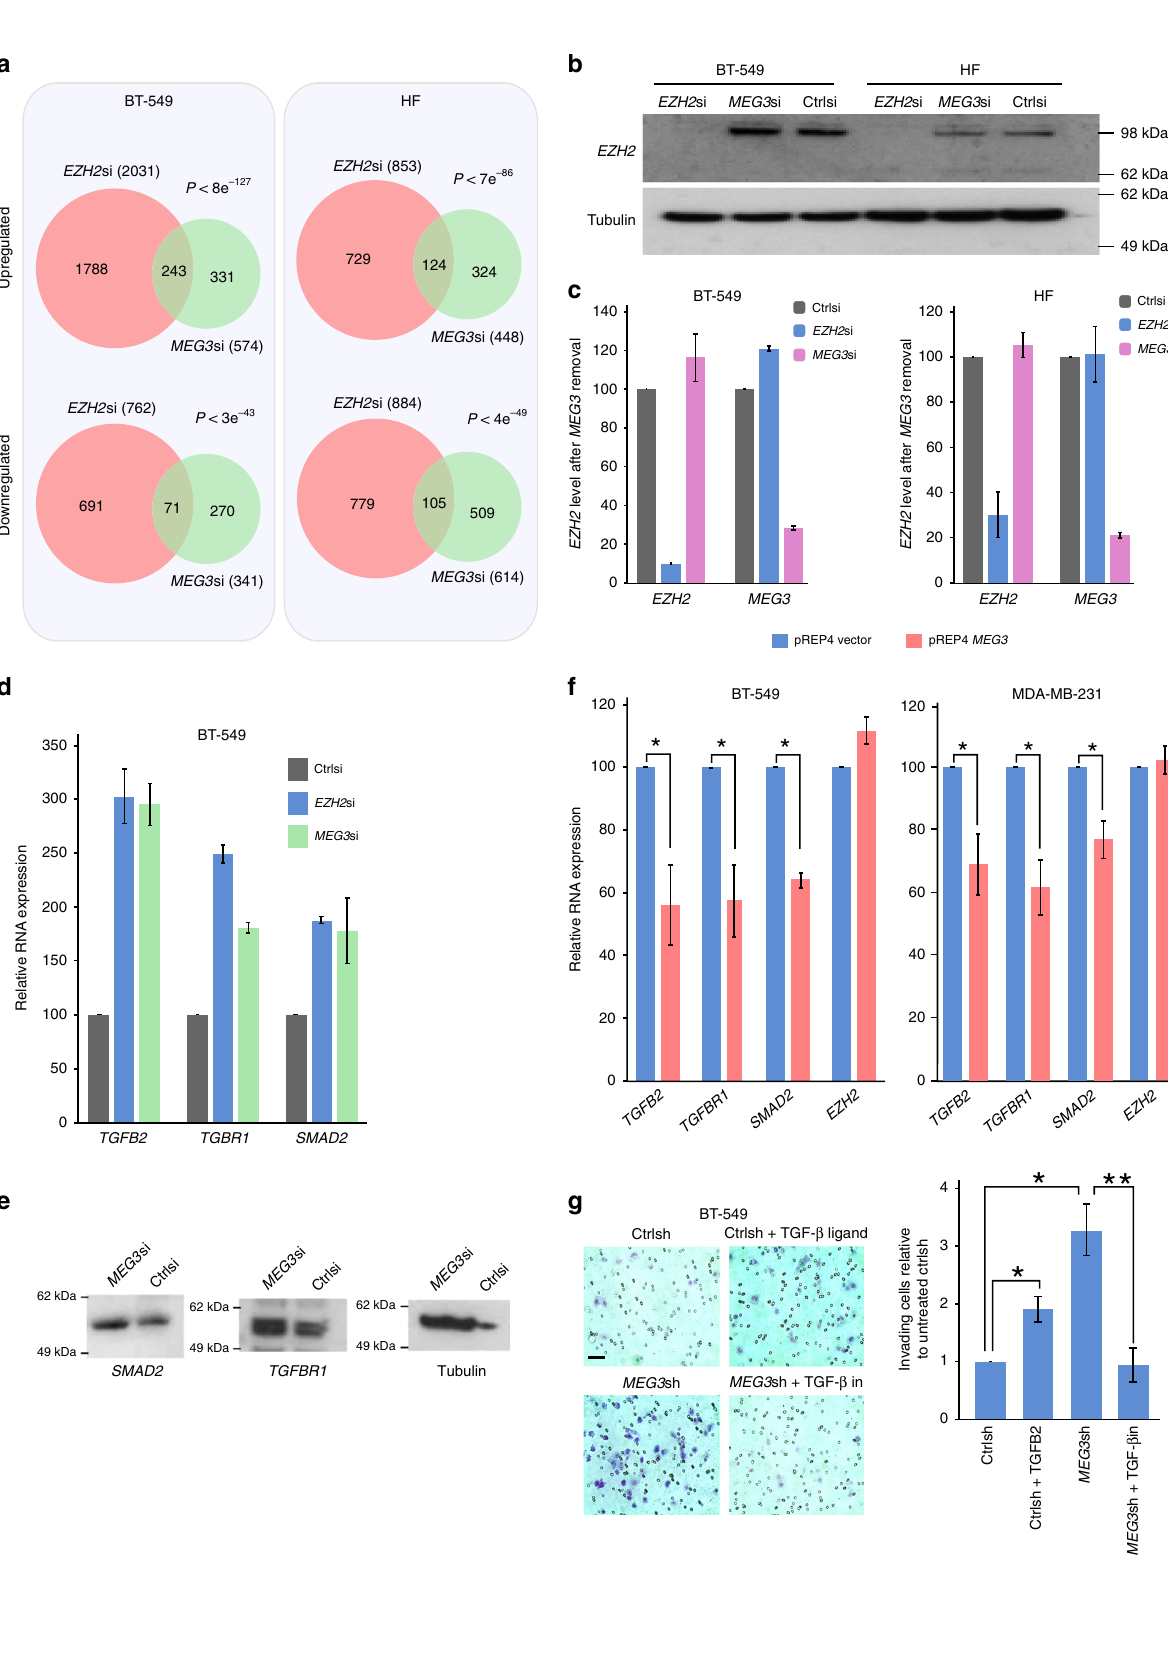
NATURE COMMUNICATIONS| (2019) 10:5290